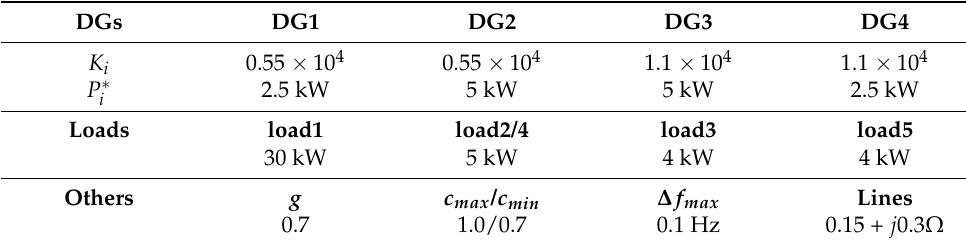
Figure 5. Five-node islanded microgrid test system. Table 2. Parameters of the test